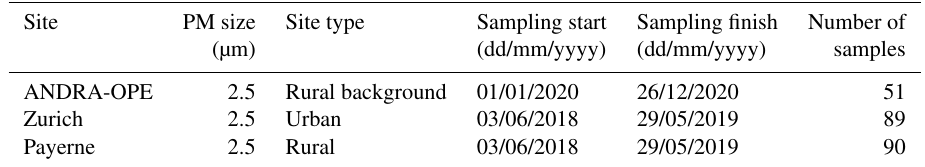
Table 2. Sampling period and site characteristics for the PM 2 . 5 sampling campaign.